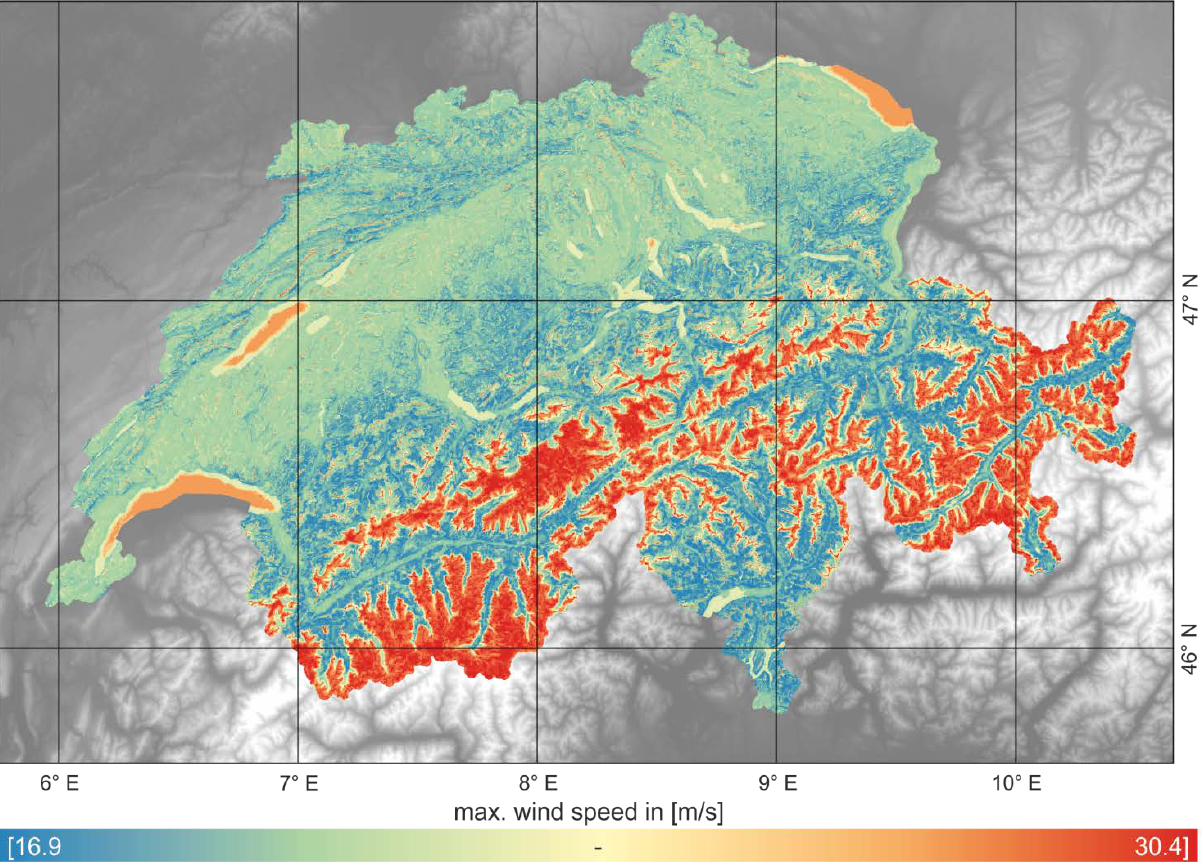
Figure 4: Map of predicted maximum wind speeds over Switzerland train error is still reduced. If overfitting was a problem in this model the test error should start raising again as soon as the model is biased by the train